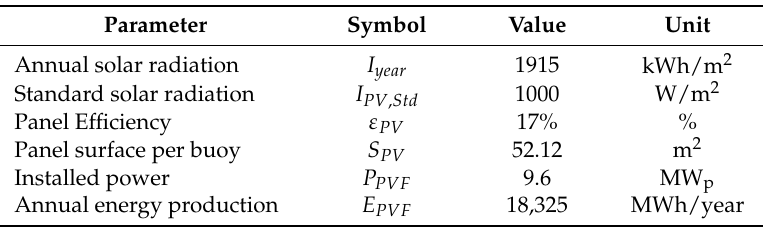
Table 3. Parameters of photovoltaic panels installed on the wave farm.